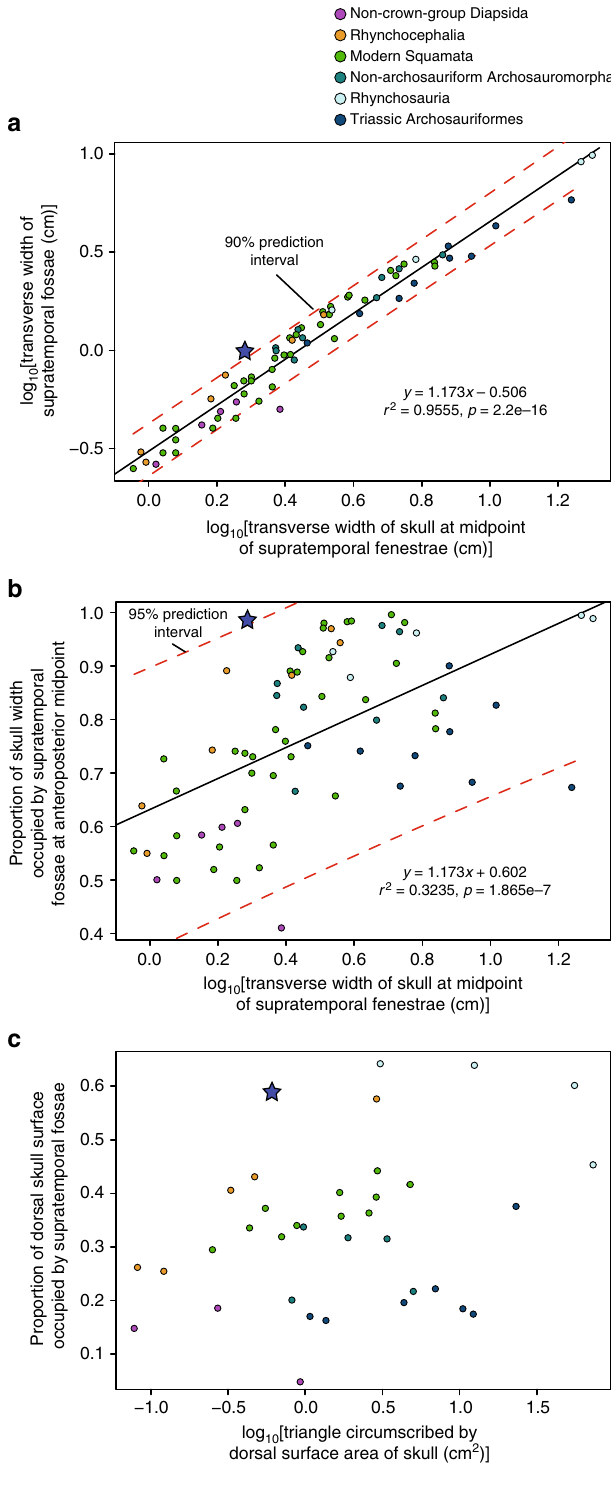
narrow, midline sagittal crest on the parietals posterior to the mandibulae profundus and m. pseudotemporalis super fi cialis. percentage of the postorbital skull width as in hyperodapedontine rhynchosaurs and Trilophosaurus buettneri .